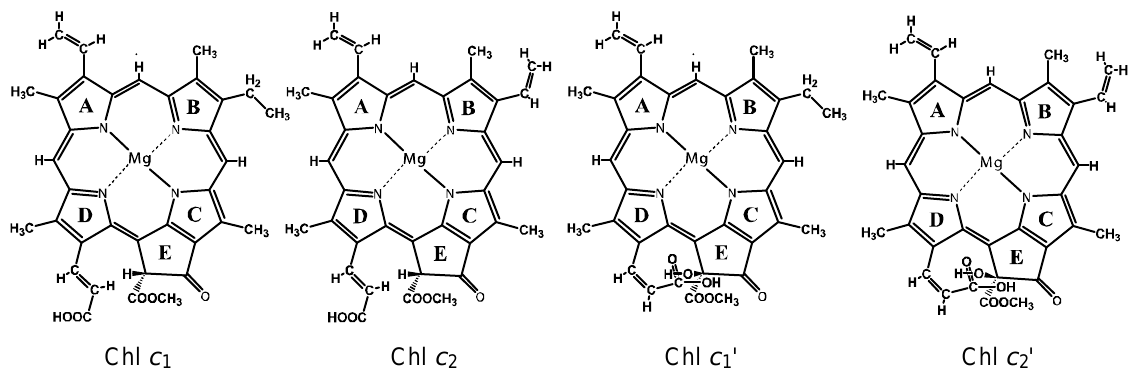
, Chl c , Chl c ’ and Chl c 1 2 1